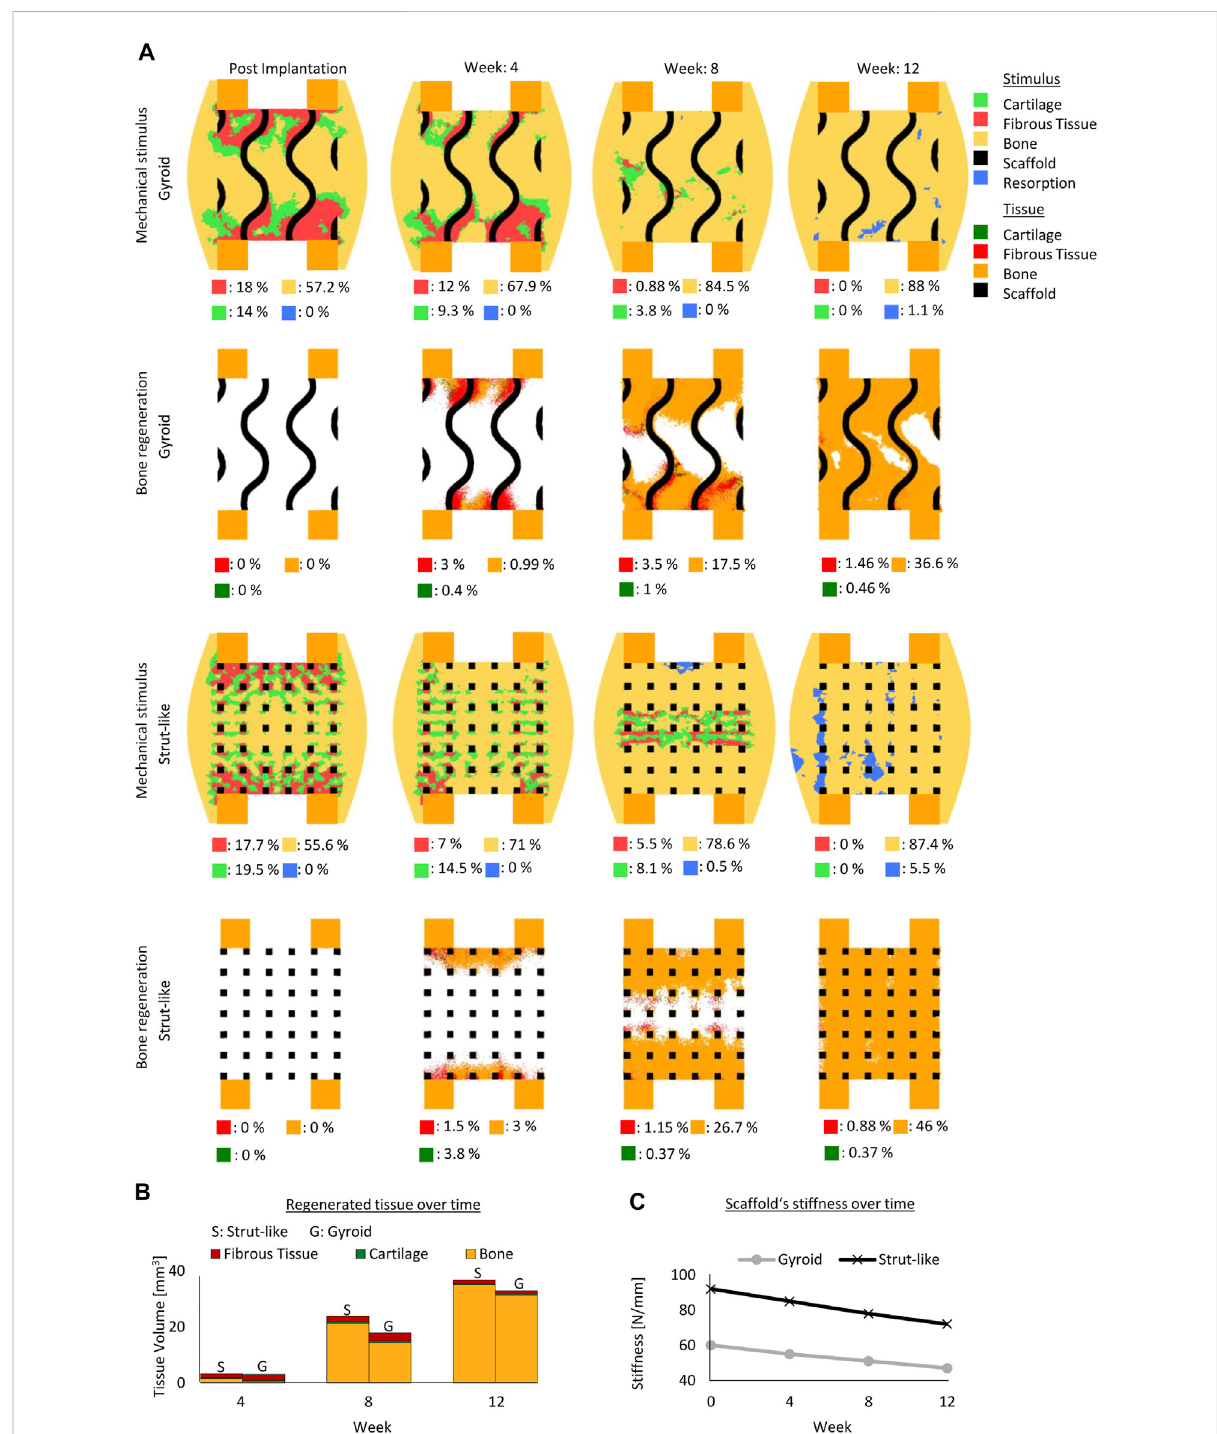
FIGURE 2 Predicted bone, cartilage and fi brous tissue within the scaffold pores at 4, 8 and 12 weeks of healing for scaffolds with strut-like and gyroid architecture with 79% porosity. (A) : Longitudinal cross sections of the callus from Figure 1A with quanti fi ed tissue regeneration in the 2D section, mechanical stimulus distribution over time using a strut-like scaffold, predicted tissue distribution over time using a strut-like scaffold, mechanical stimulusdistributionovertimeusingagyroidscaffoldandpredictedtissuedistributionovertimeusingagyroidscaffold. (B) :Totaltissuevolume predicted within thescaffold pores atdifferentstages ofhealing. (C) :Mechanicalstiffness ofscaffoldscomputed fromcompression tests atdifferent stages of